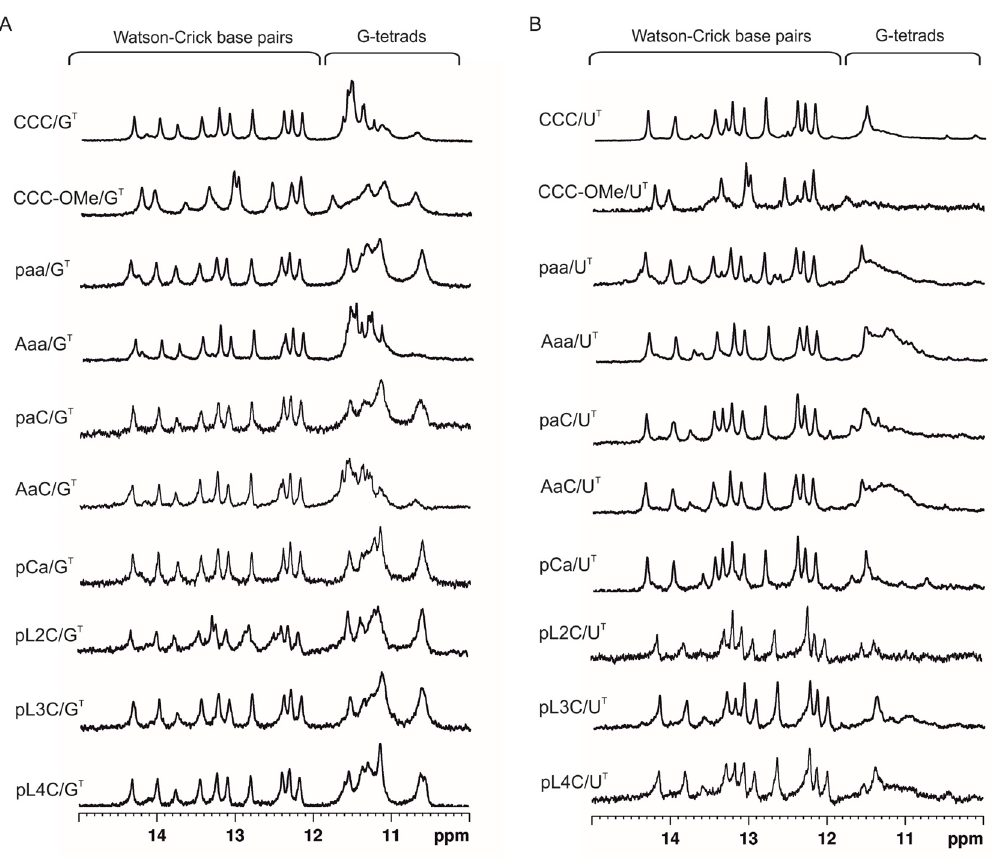
Figure 7. Comparison of imino region of the 1 H NMR spectra of CCC/G T , CCC-OMe/G T , paa/G T , Aaa/G T , paC/G T , AaC/G T , pCa/G T , pL2C/G T , pL3C/G T , pL4C/G T ( A ) and CCC/U T , CCC-OMe/U T , paa/U T , Aaa/U T , paC/U T , AaC/U T , pCa/U T , pL2C/U T , pL3C/U T , pL4C/U complexes ( B ) at 25 °C in the presence of 50 mM KCl, 10 mM potassium phosphate, 0.1 mM EDTA, pH 6.8.